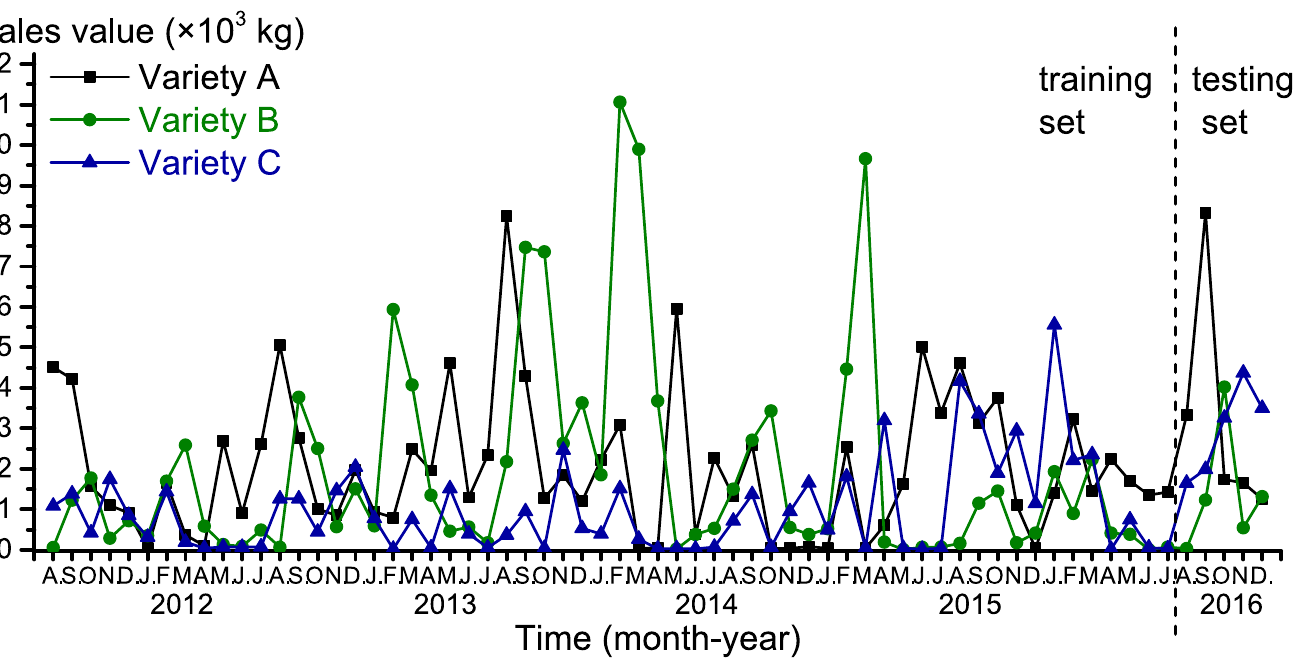
Fig 2. Historical monthly sales data for the three spring onion seed varieties between August 2011 and December 2016.